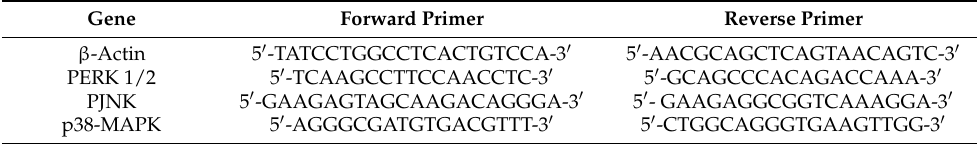
Table 1. The primer sequence of genes selected for polymerase chain analysis.